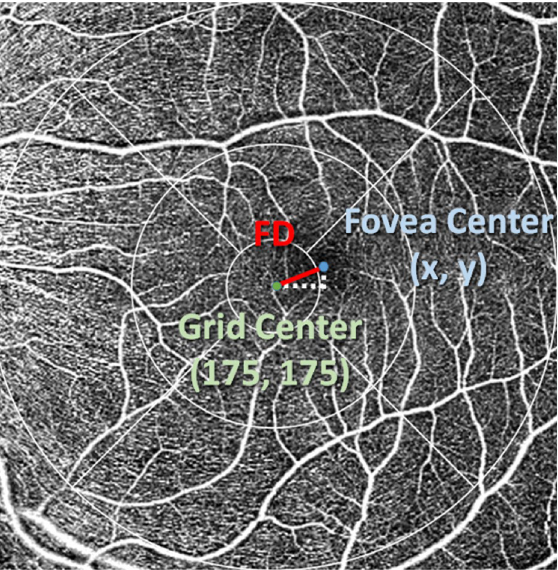
Figure 1. Coordinates of foveal center are x, y. Fixation deviation (FD) in pixel was calculated as distance between grid center and foveal center using the formula below. FD = (cid:31) ( 175 − x )